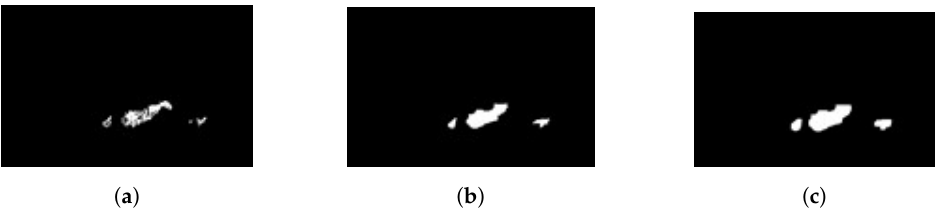
Figure 4. The sample results of morphology operations as post-processing. ( a ) Segmentation result; ( b ) closing operation result; ( c ) dilation operation